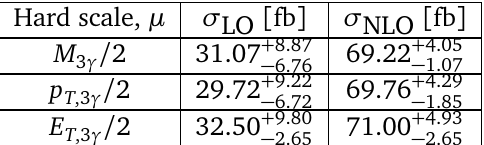
(cid:112) s = 8 TeV for the = µ ), errors indicate F R